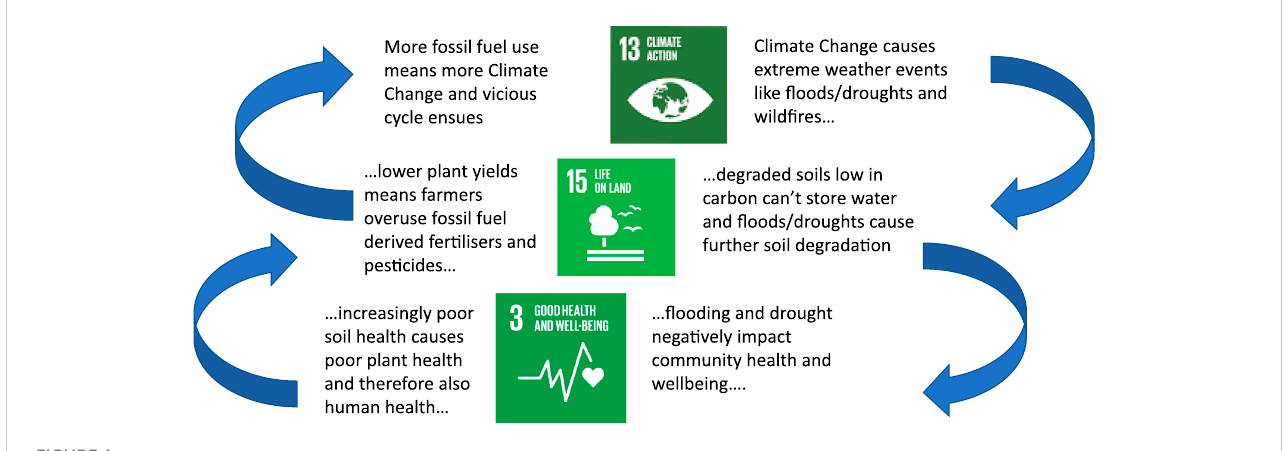
FIGURE 1 Simpli fi ed vicious cycle of soil degradation and climate change linking SDG3 (human health) with SDG15 (soil and plant health) and SDG13 (climate change). Both the extreme weather events associated with climate change and soil degradation caused by these negatively impact human